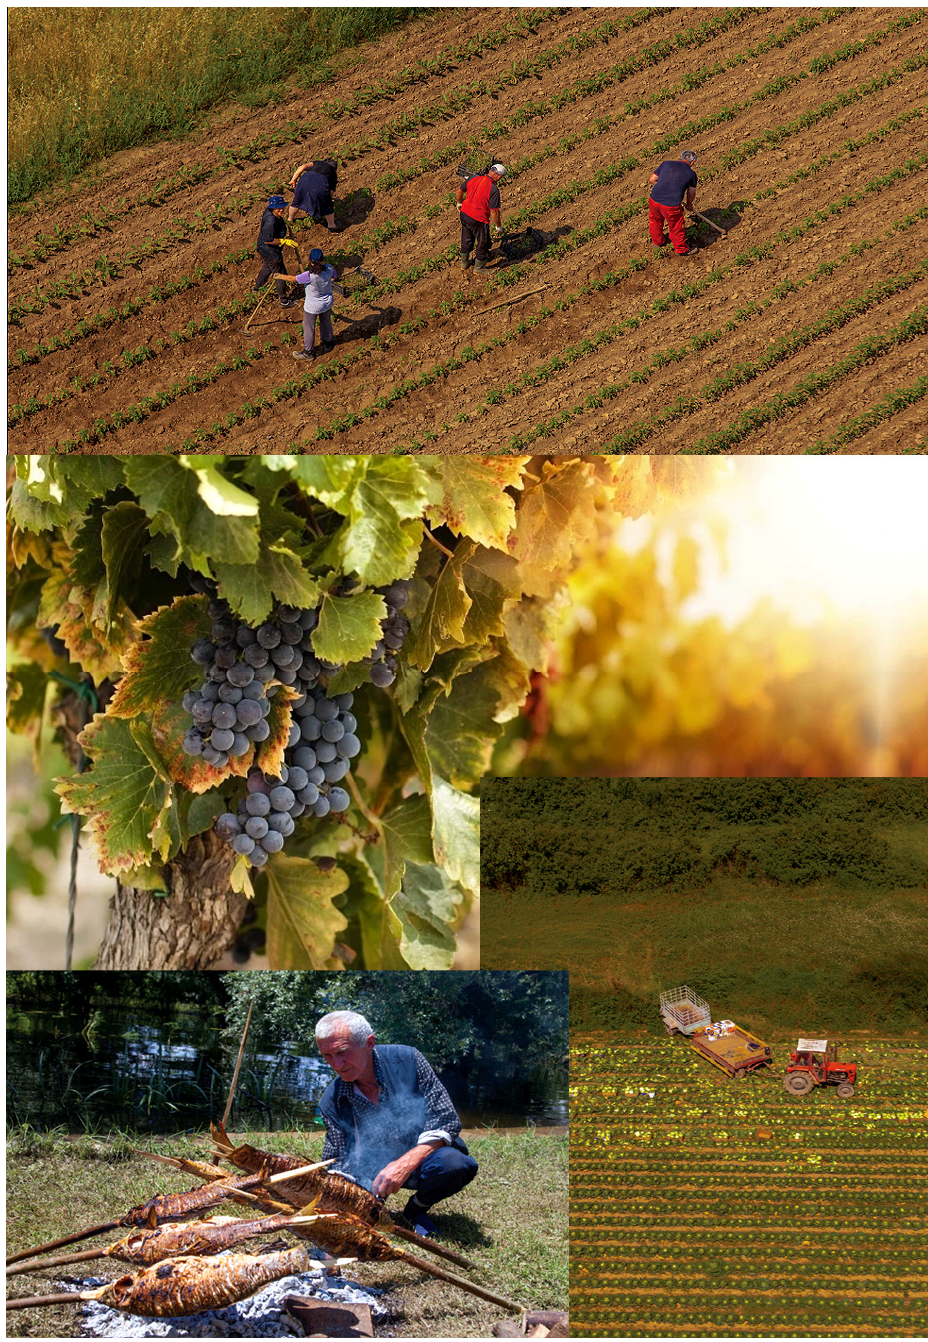
Figure 23. Agriculture activities in the Zeta region, Montenegro (Photo: D. Star č evi ć , [40]). The studied region is seismically active, with a history of earthquakes and the possi- bility for catastrophic events. “Kamen”—hard natural stone taken from nearby—is one of the basic materials used in the construction of traditional Zeta houses. The good quality and resilience of the local material (“kamen”) explains the durability of the traditional Zeta houses. This material is well received by the local population, as the stones are con- sidered a good choice for stabilization of indoor temperatures during the extremely hot summers when temperatures exceed 30 °C (June–September). Temperatures during July and August can exceed 40 °C [40,41].